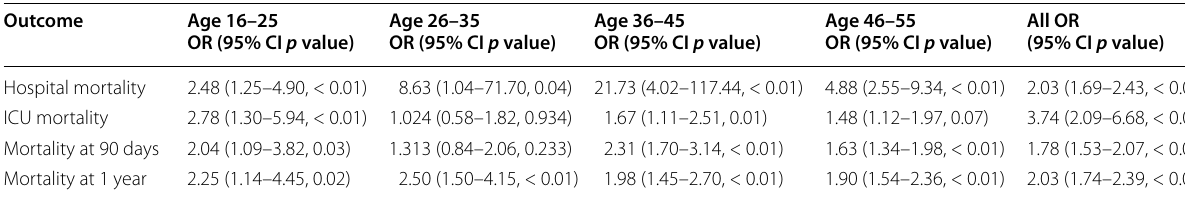
OR odds ratio, CI confidence interval, ICU Intensive Care Unit